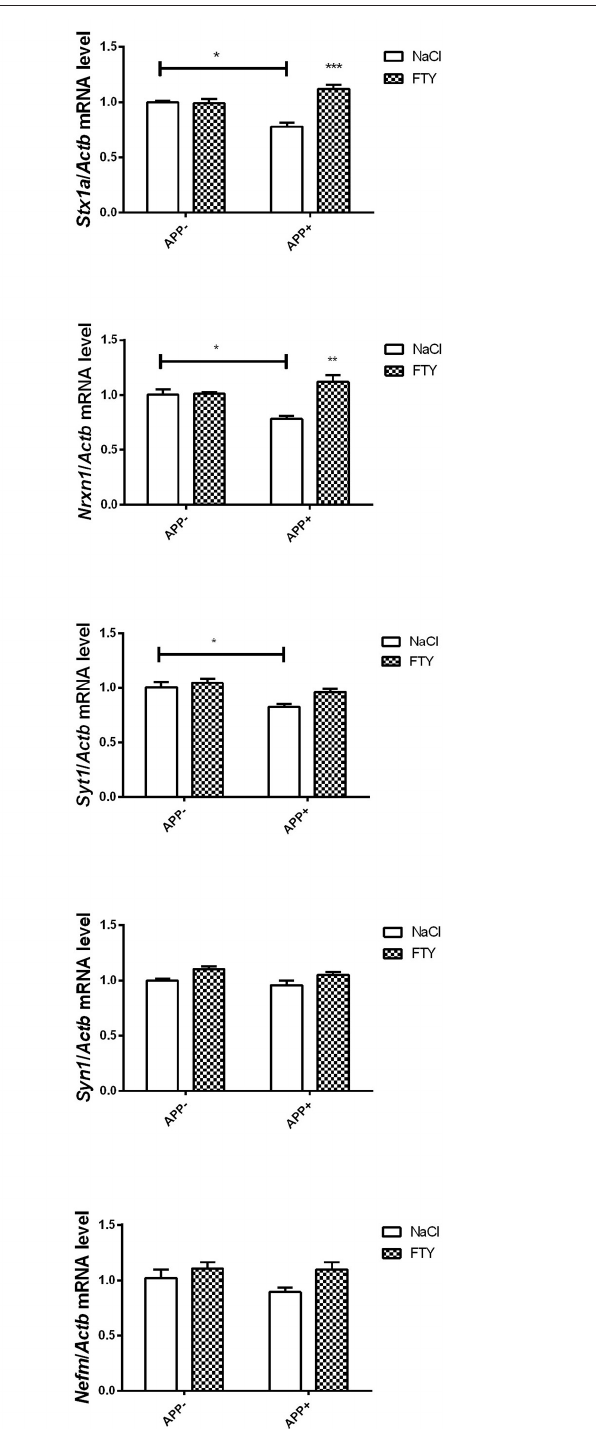
Frontiers in Molecular Neuroscience |